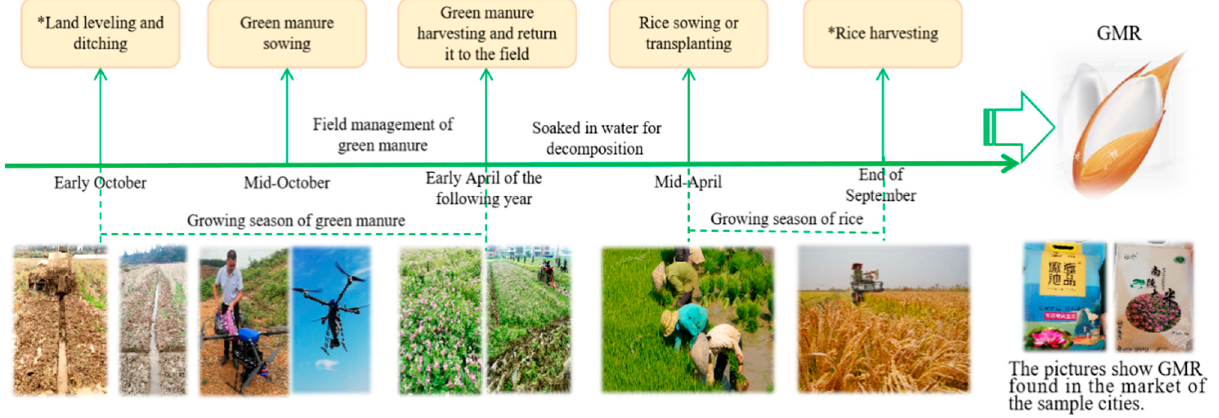
Figure 1. The process of GMR production.